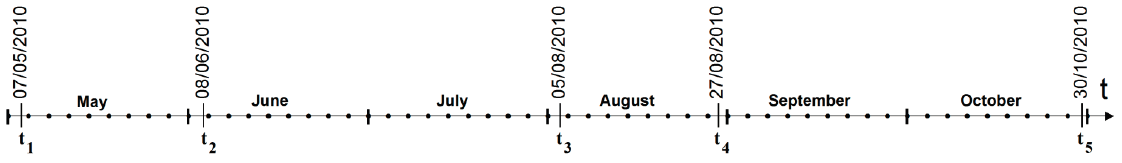
Figure 4. The acquisition dates of the images used in the